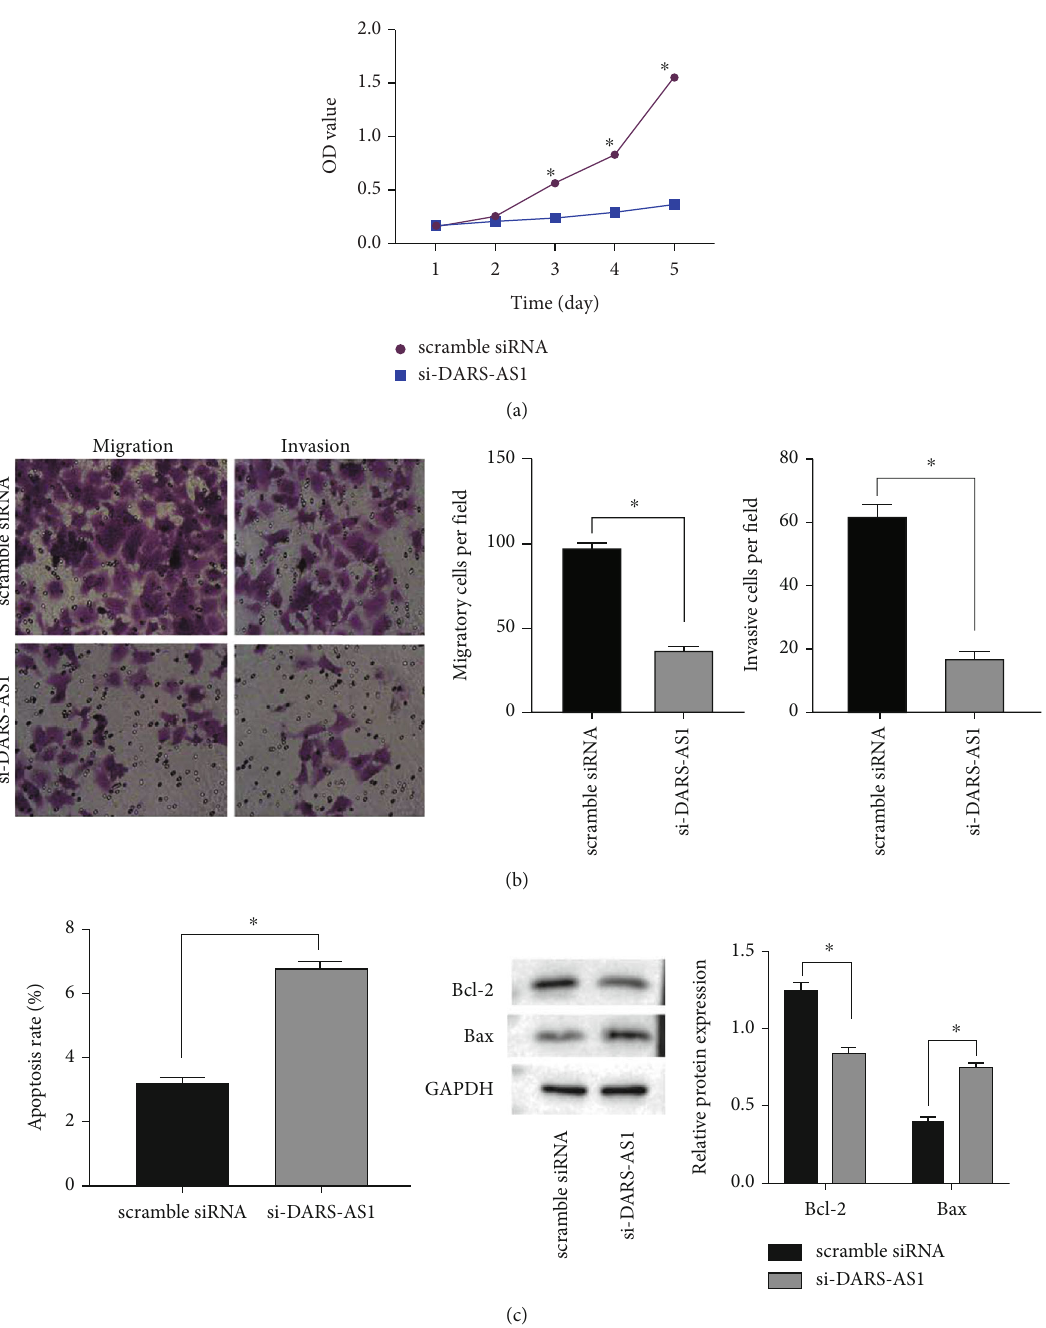
Figure 2: lncRNA DARS-AS1 knockdown regulates OC cell behaviors. (a) CCK-8 assay detection of A2780 cell viability after lncRNA DARS-AS1 knockdown. (b) Representative migratory or invasive A2780 cells per fi eld and numbers of migratory or invasive cells after lncRNA DARS-AS1 knockdown. (c) Apoptosis rates of A2780 cells, western blots, and gray values of apoptosis-related proteins in A2780 cells after lncRNA DARS-AS1 knockdown. A symbol of ∗ represents p < 0 : 05